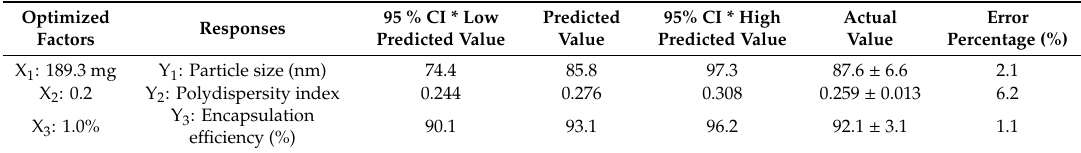
Table 4. Predicted and actual values of responses for optimized ticagrelor-loaded nanostructured lipid carriers (TGL-NLC). Actual values are expressed as mean ± SD (n =